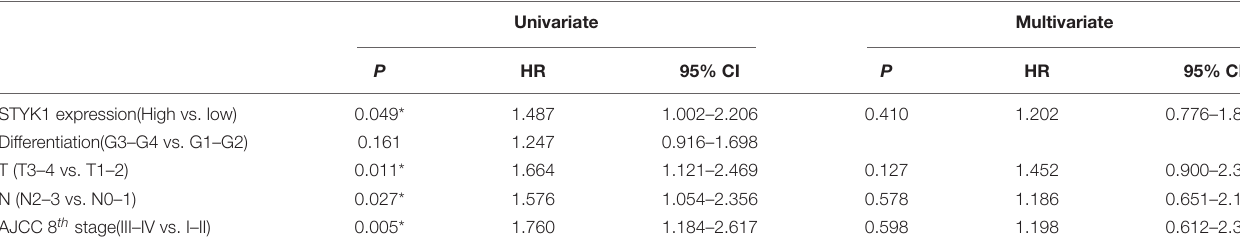
TABLE 2 | Univariate and multivariate Cox regression analysis of prognostic factors for 5-year postoperative survival in patients with NSCLC. Univariate Multivariate P HR 95% CI P HR 95%